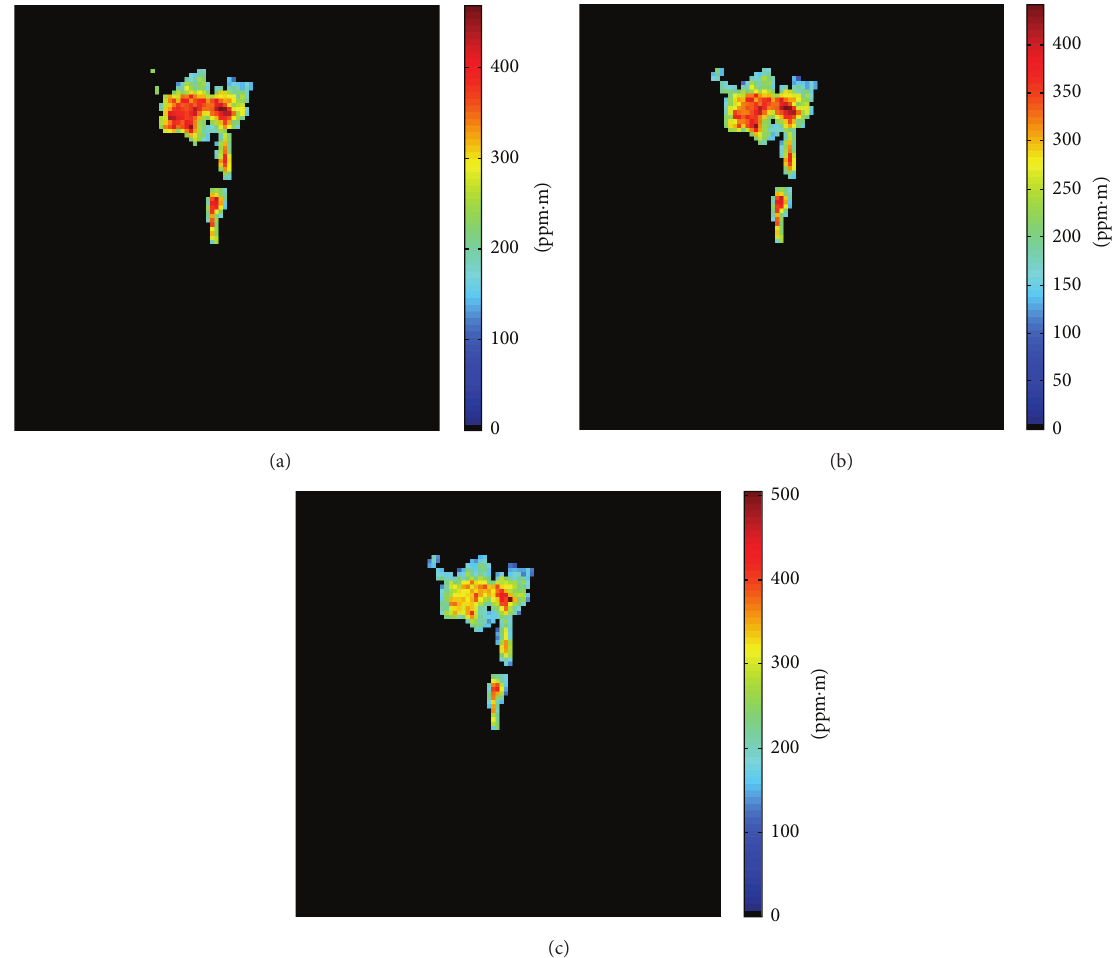
Figure 19: Retrieved ethylene concentration (ppm ⋅ m) from the three estimated L method. (c) Clustering-Based Selected-Band